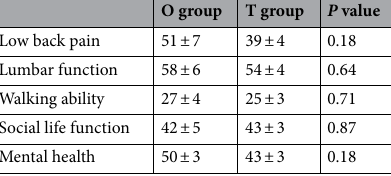
Table 4. Preoperative the Japanese orthopedic association back pain evaluation questionnaire